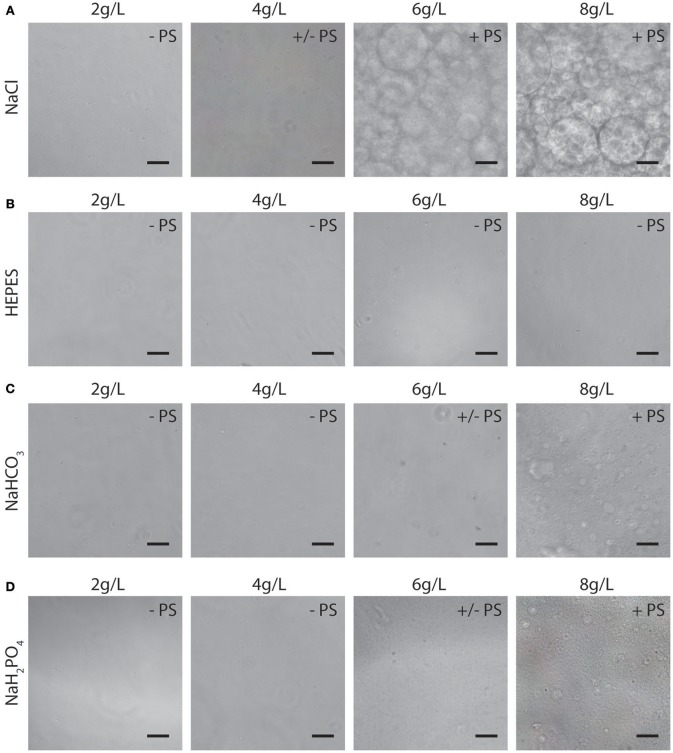
Representative images (10X) of microdroplet emulsions in PEO 900 kDa-BSA systems with addition of NaCl (A), HEPES (B), NaHCO3
(C), NAH2PO4
(D). PS: no phase separation; +/– PS: near critical system/slight phase separation; + PS: super-critical system with apparent phase separation. Scale bars are 50 μm.